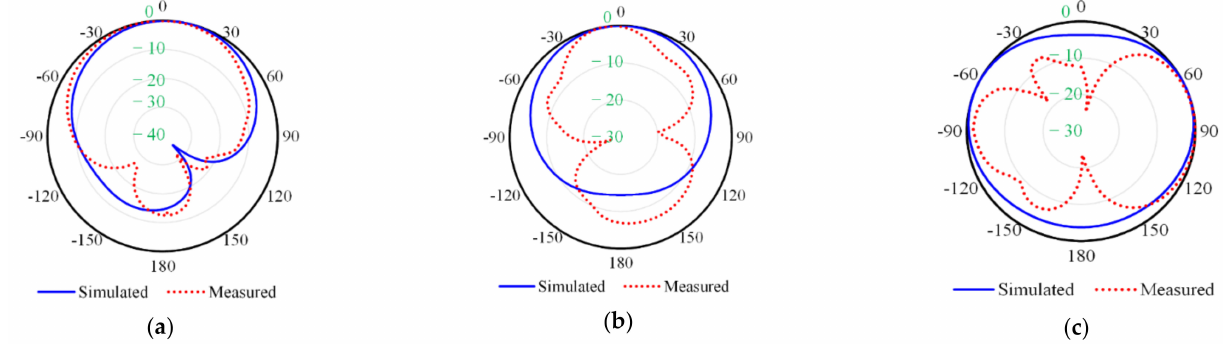
Figure 14. The simulated and measured radiation pattern of the proposed antenna at 2.45 GHz on the ( a ) xz-plane, ( b ) yz-plane, and ( c )